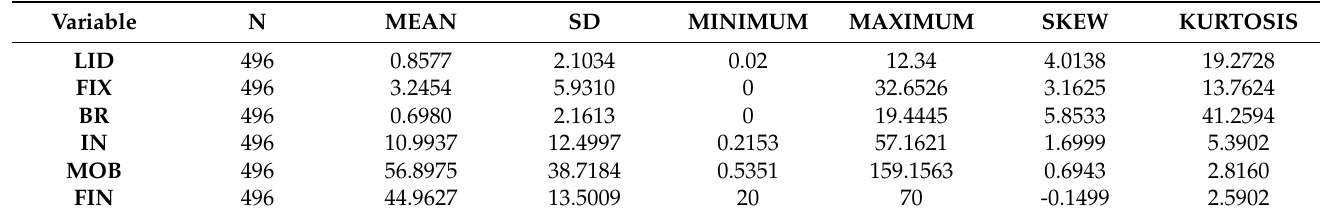
Table 3. Summary